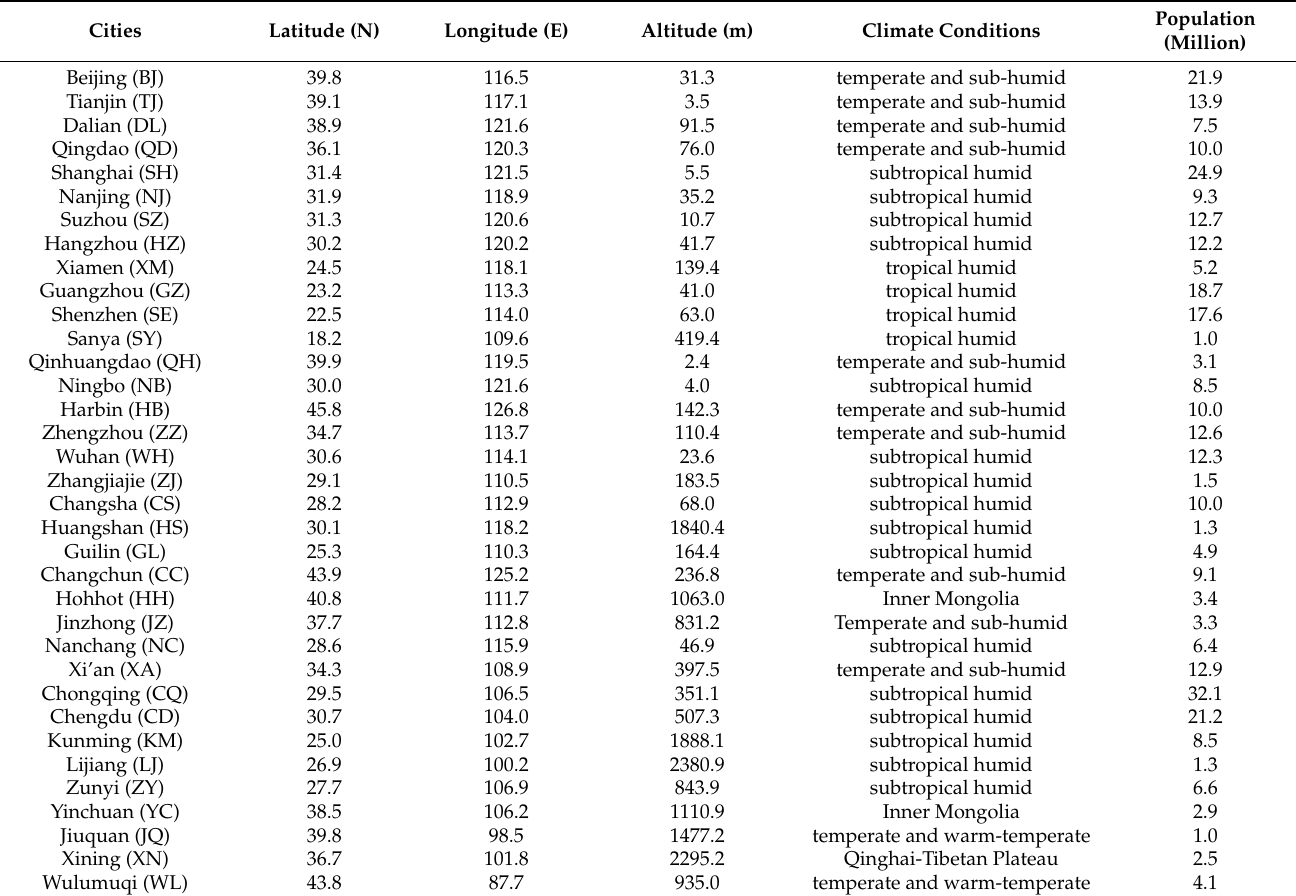
Table 1. Detailed information of the tourism cities in